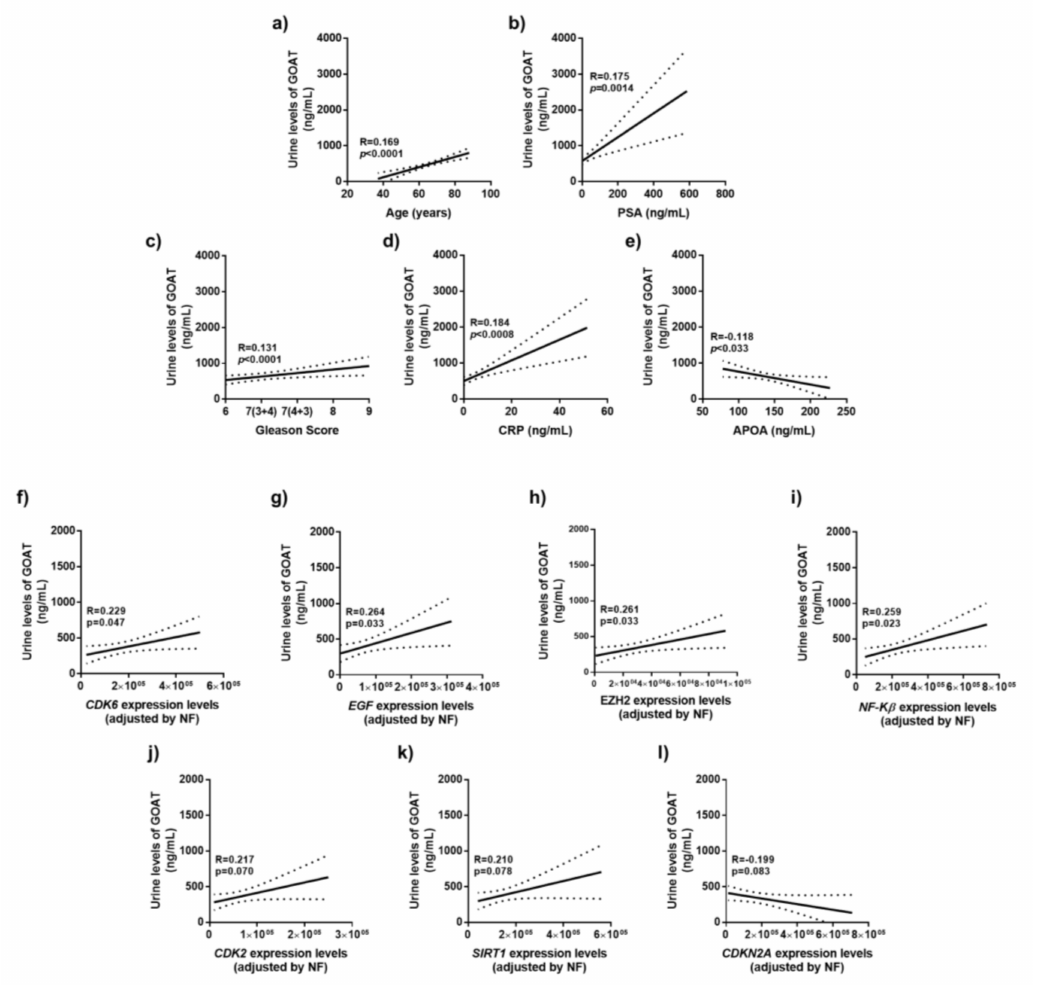
Figure 2. Correlations of urine GOAT levels and molecular parameters. Correlations of urine GOAT levels in PCa patients with the tissue expression levels of CDK6 , EGF , EZH2 , NF-KB , CDK2 , SIRT1 and CDKN2A . mRNA levels were determined by qPCR and adjusted by a normalization factor (calculated with the expression levels of ACTB and GAPDH using GeNorm). Coe ffi cients of correlation (R) were evaluated by Pearson’s test. The graphics show the lineal adjusted method and mean confidence